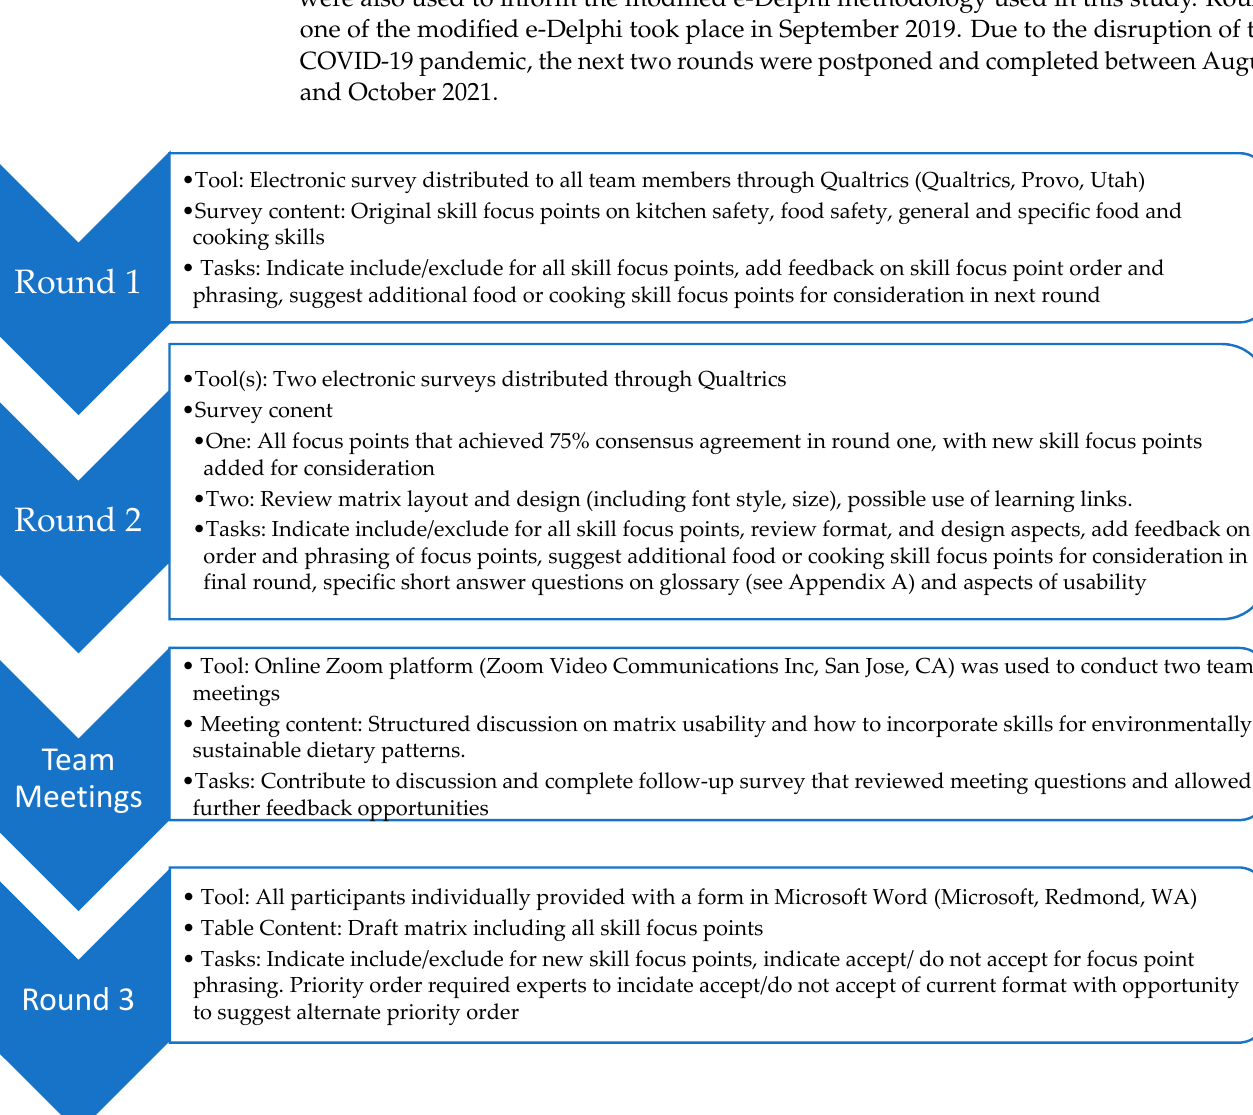
Figure 1 . The modified e ‐ Delphi process used in this study. Figure 1. The modified e-Delphi process used in this